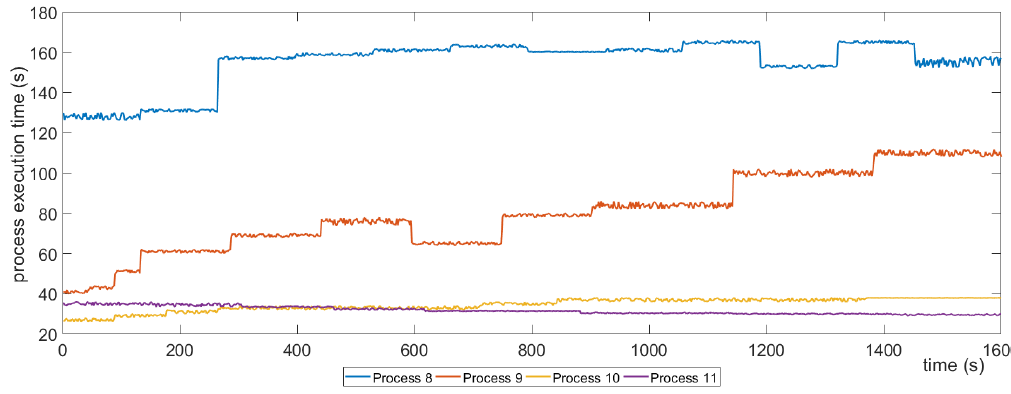
Figure 28. Low priority